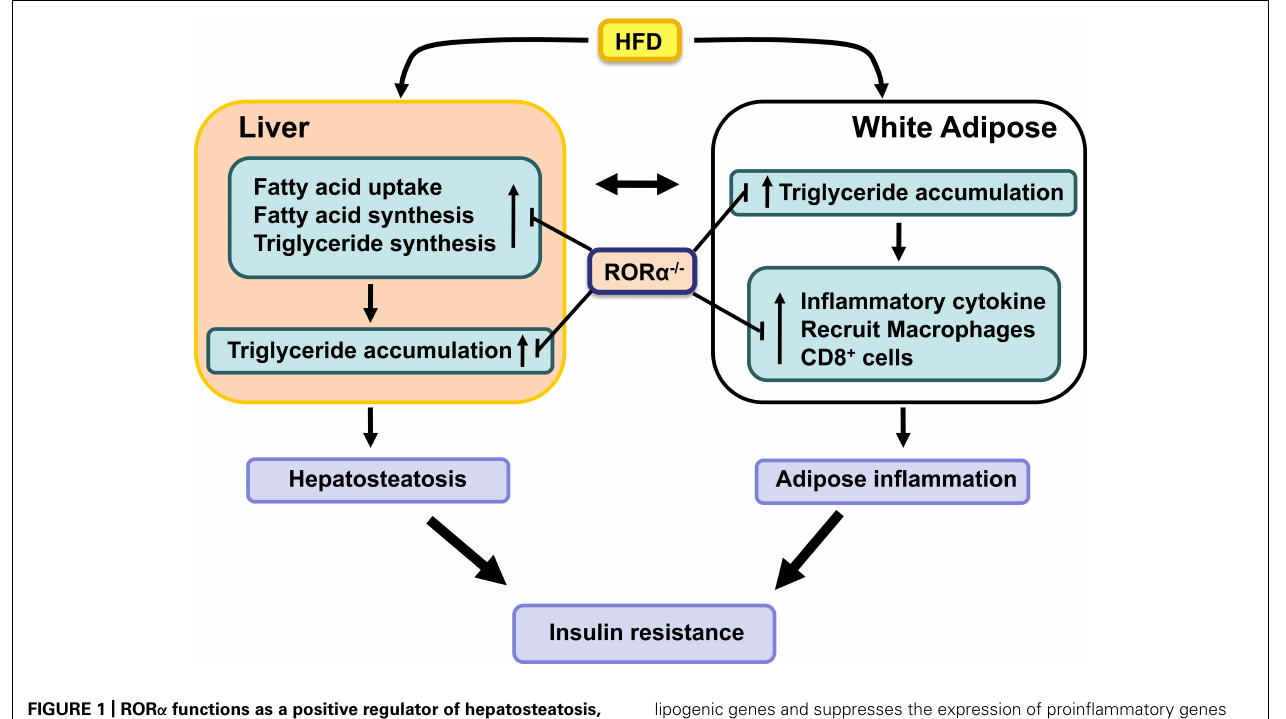
lipogenic genes and suppresses the expression of proinflammatory genes and the infiltration of macrophages inWAT, and as a result protects against these